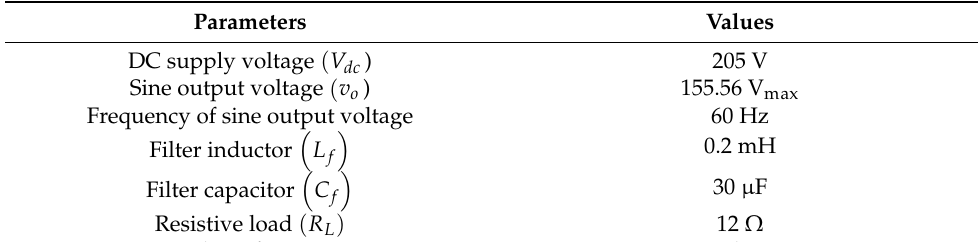
Table 1. Parameters of the sine-wave inverter with inductor-capacitor filter.